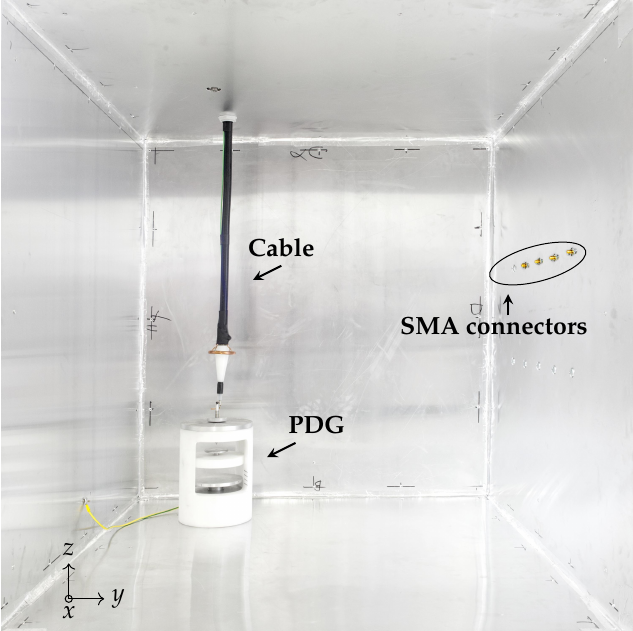
Figure 4. PD generation. The PDG, cable and SMA connectors (correspondent to the probes